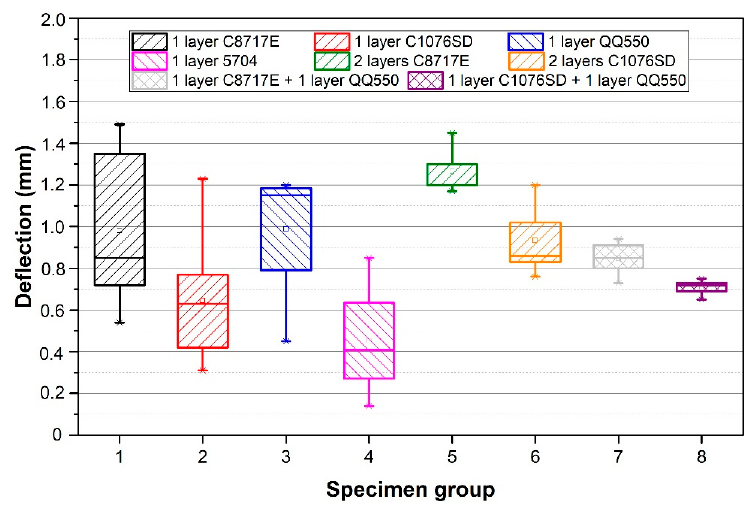
Figure 5. Results of deflection measurement for all specimen groups.